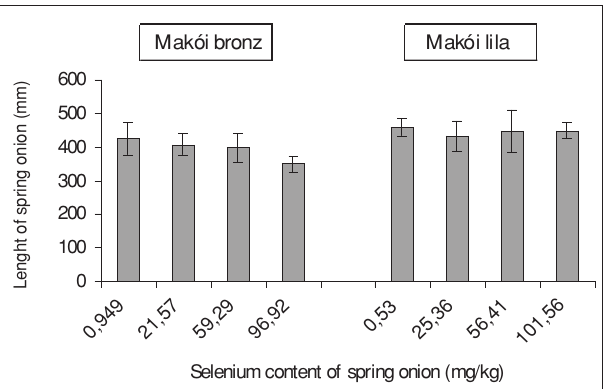
56 41 36 53 101 , 56 , 25 , 0 ,